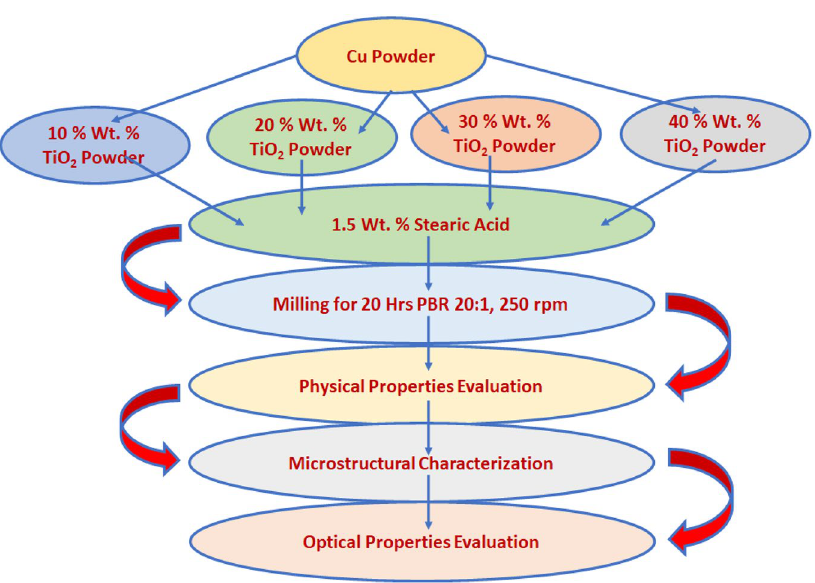
Figure 1. Schematic diagram for fabrication of Cu–TiO 2 composite powders at a different weight percent of TiO 2 10, 20, 30, and 40